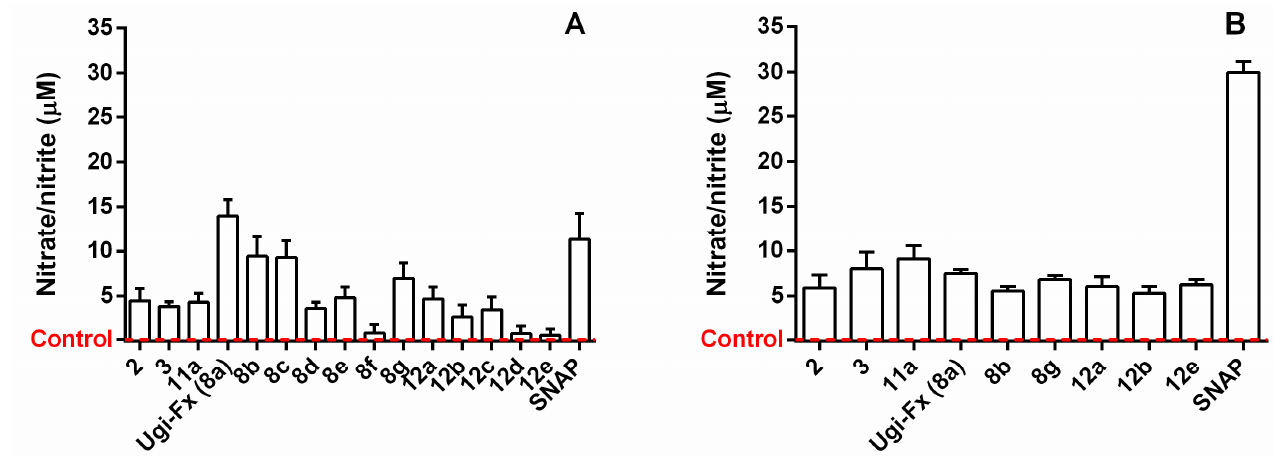
Figure 3. Levels of · NO produced by Ugi-furoxan and GBB-furoxan derivatives ( A ) in T24 cells and ( B ) in LNCaP cells. The results are the means ± SD of three independent experiments. SNAP is the · NO-releasing positive control compound. The red dotted line indicates the baseline, corresponding to the negative control that was treated only with culture medium.